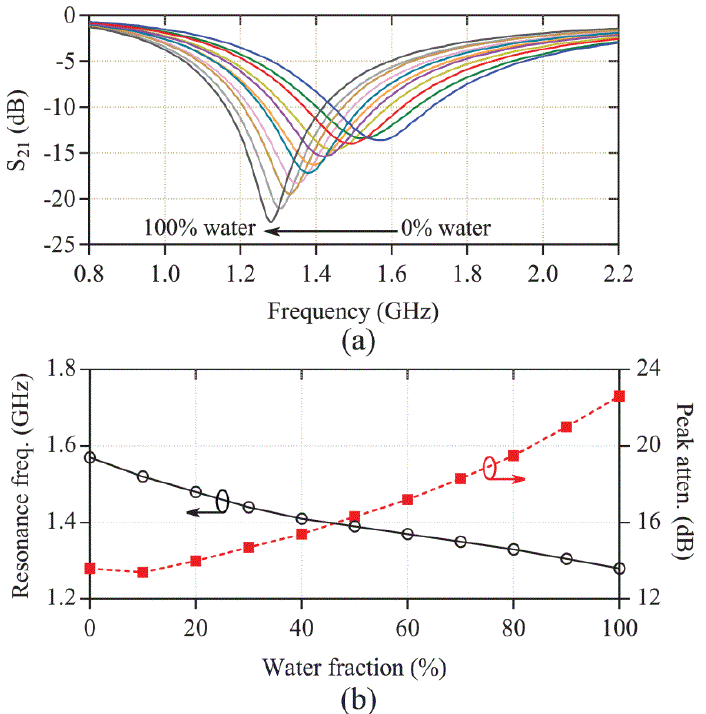
Figure 10. Measured frequency response of the sensor for various water-methanol solutions ( a ) and representation of the resonance frequency and notch magnitude as a function of the water concentration ( b ). From [46], reprinted with permission. In panel (a), the step variation of water content is 10%.